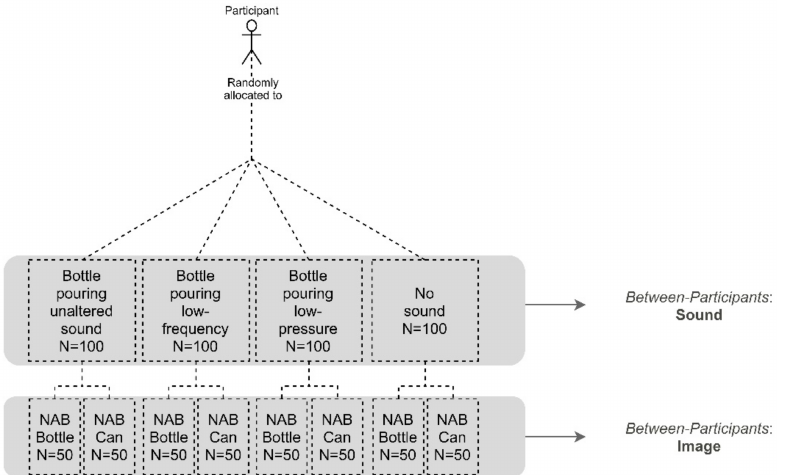
Figure 2. Design of Experiment 2 including the two types of stimuli (sound and image) employed simultaneously in the between-participants